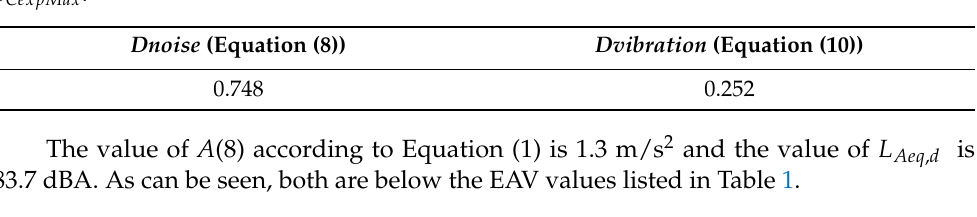
Table 5. Dvibration and Dnoise achieved for the combined recommended maximum exposure time T CexpMax